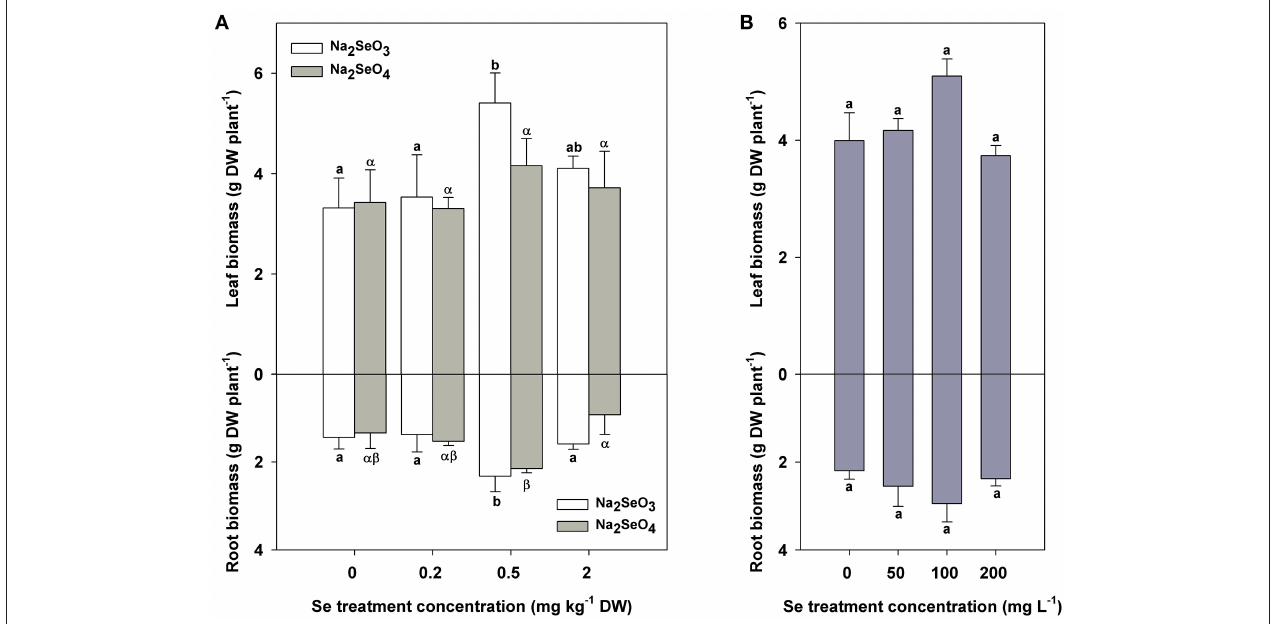
FIGURE 1 | Biomass accumulation (g plant − 1 DW) of turnip plants under different Se treatment modes. (A) Biomass differences of turnip leaves (top) and roots (bottom) treated with different concentrations of Se (IV) or Se (VI) by soil addition. (B) Biomass differences of turnip leaves (top) and roots (bottom) treated with different concentrations of Se (IV) by foliar application. Data represent means ± SE ( n = 3). Bars labeled with different letters (a, b or α , β ) are significantly different among different Se treatment concentrations of Se (IV) or Se (VI) ( P < 0.05) (A,B) .